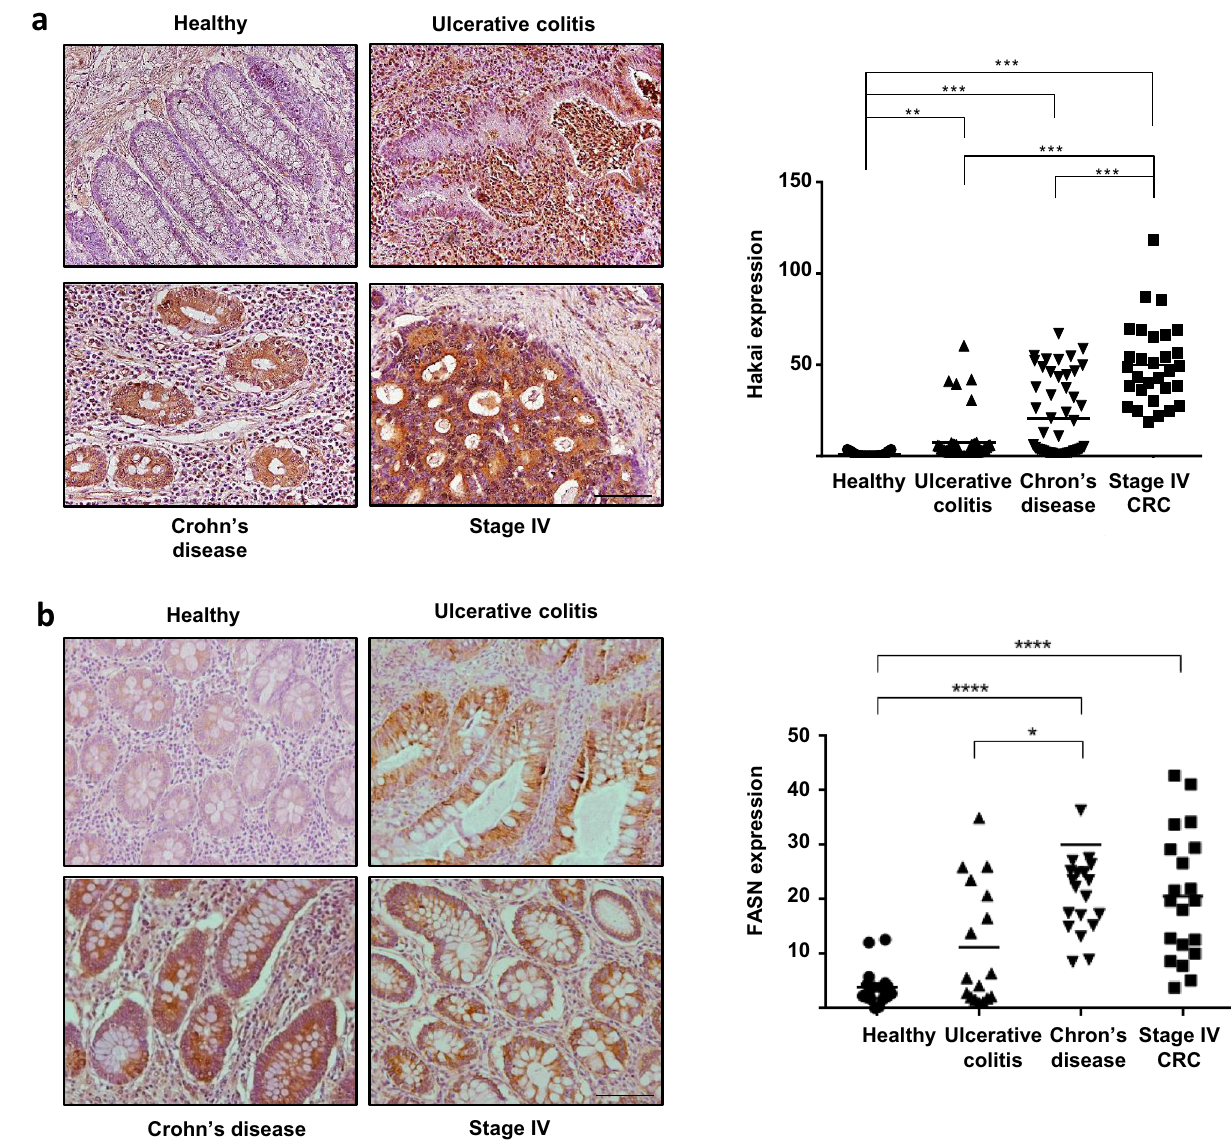
Figure 6. Expression of Hakai in human samples of UC, CD and colorectal adenocarcinoma stage IV and its healthy tissue pairs. ( a ) Immunohistochemistry staining of Hakai (left panel) and quantification (right panel) in healthy colonic mucosa, UC, CD and colorectal adenocarcinoma TNM-stage IV. Images obtained with 20 × objective. Scale bar 125 μm. ( b ) Staining intensity of FASN (left panel) and quantification (right panel) in healthy colonic mucosa, UC, CD and colorectal adenocarcinoma TNM-stage IV. (Normal colonic mucosa, n = 6, UC, n = 8; CD, n = 10; and colorectal adenocarcinoma, n = 6). Five pictures of each sample were taken and quantified. Data are represented as scatter plot. Values are means ± SEM of staining intensity signal scoring per area. Quantification and calibration of the images were performed with immunohistochemistry Image Analysis Toolbox software for Image J. Kruskal–Wallis with Tukey correction test analyses show statistical differences in colorectal cancer (TNM, SI-IV) respect to paired healthy samples (*p < 0.05; **p < 0,01; ***p < 0,001). Scale bar 125